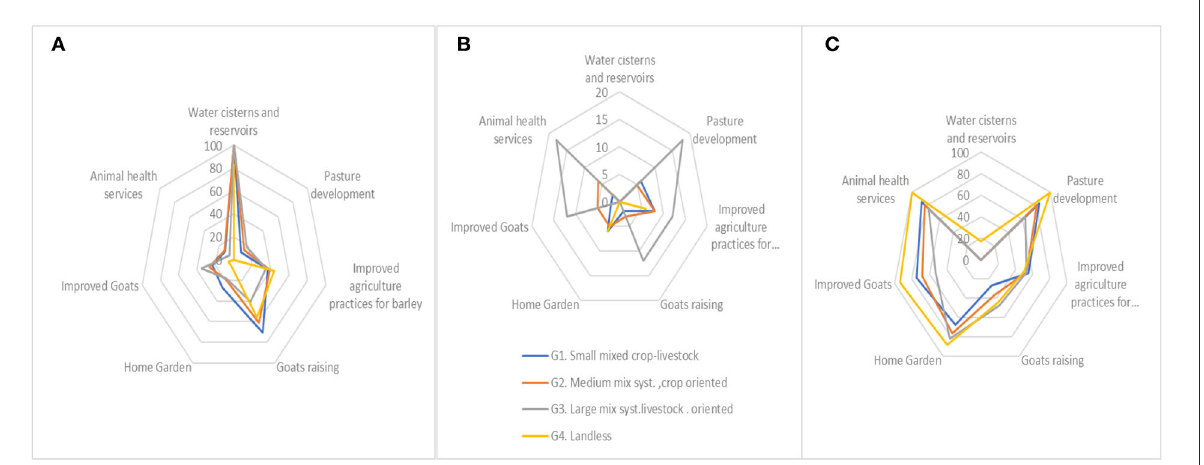
FIGURE5 Clustering of